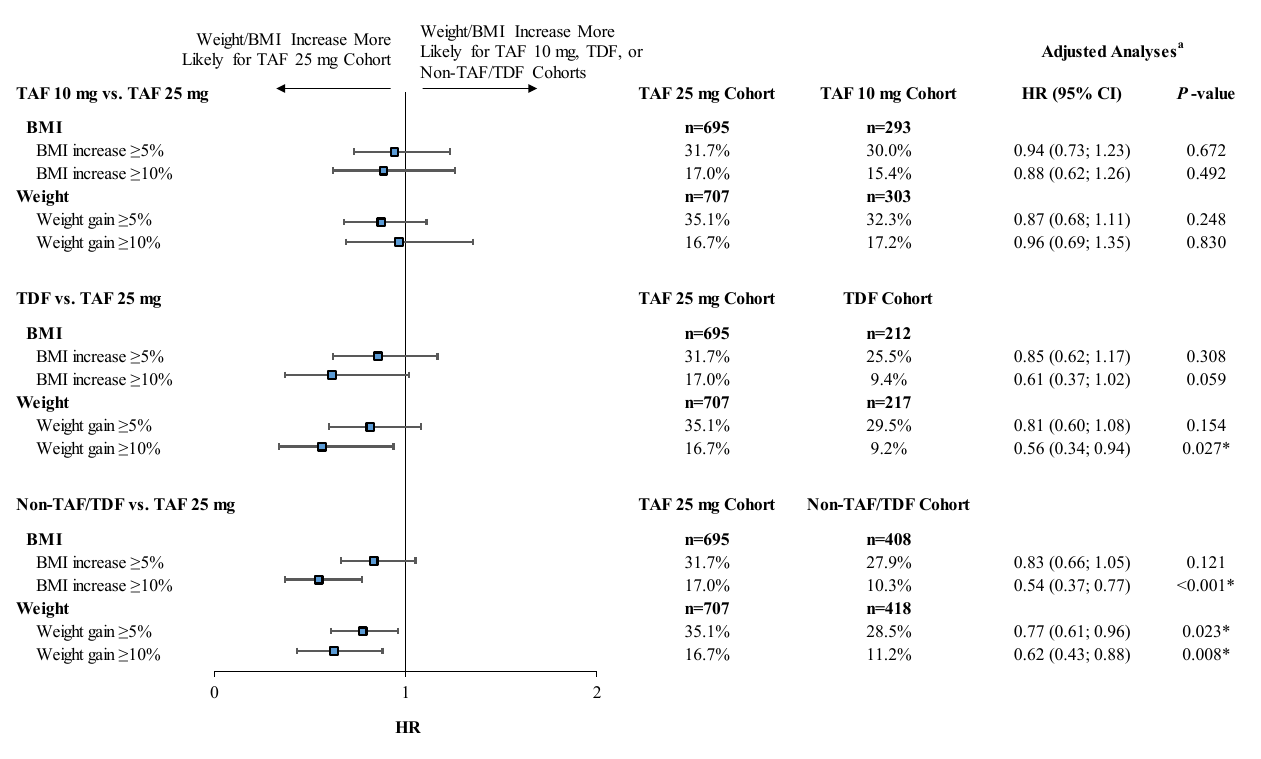
Figure 5. Comparison of Time to Weight Gain or BMI Increase ≥5% or ≥10%